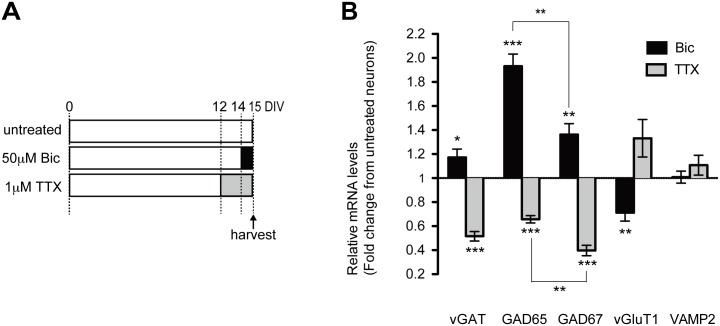
Different bidirectional forms of activity-dependent gene regulation governing GAD expression.(A) Cultured cortical neurons were treated with 50 μM bicuculline on DIV14 or with 1 μM TTX on DIV12 and were harvested on DIV15. (B) Shows reciprocal effects of bicuculline and TTX on relative expression levels of mRNAs encoding GABAergic and glutamatergic presynaptic proteins in cultured cortical neurons treated as shown in (A). GAD67: F(2, 14) = 106.5 (p < .0001); GAD65: F (2, 14) = 62.36 (p < .0001); vGluT1: F(2, 14) = 11.52 (p = 0.001); VAMP2: F(2, 14) = 1.26 (no significant difference, p = 0.31), one-way ANOVA. (n = 5–6 in each group). GAD: glutamic acid decarboxylase; DIV: days in vitro; TTX: tetrodotoxin.